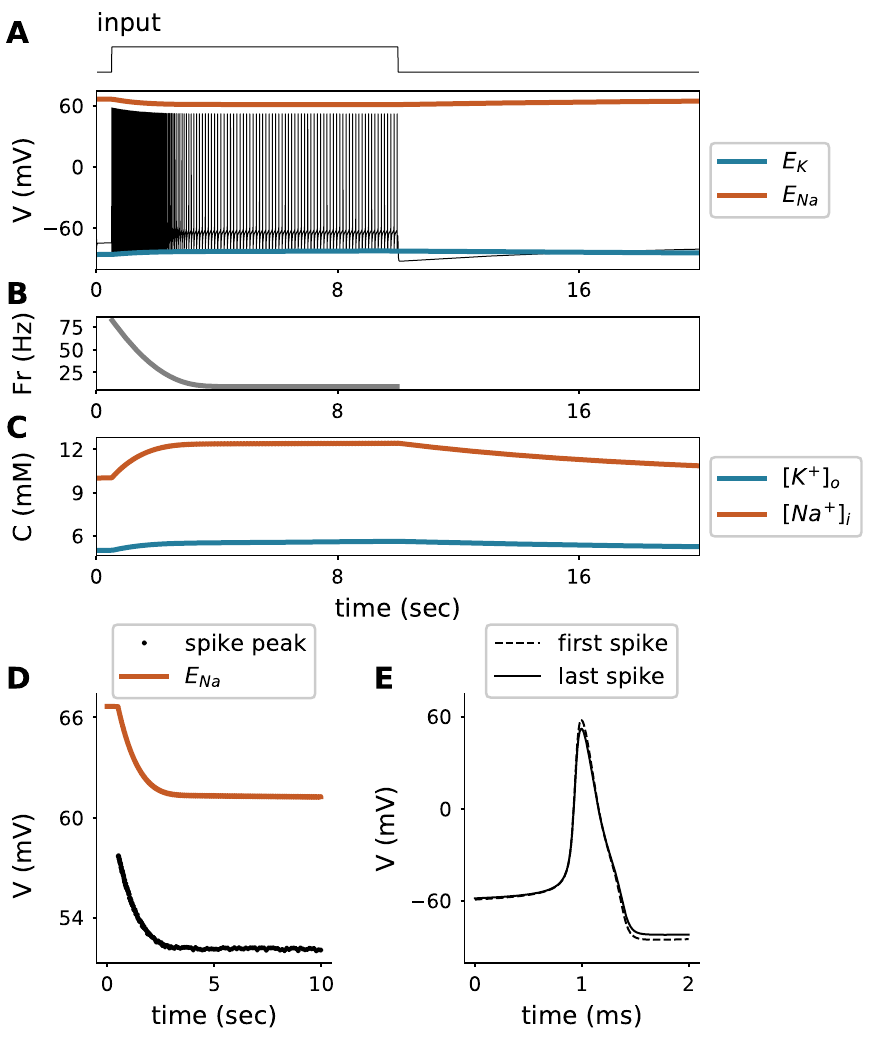
Fig 1. Response of the model to a step current of 2 μA / cm 2 input as shown in the top. A . Voltage trace (V) with reversal potentials for sodium (Orange) and potassium (Blue). B . Firing rate (Fr) of neuron model. C . Intracellular sodium (Orange) and extracellular potassium (Blue) concentration (C) dynamics. D . Spike amplitude and reversal potential for sodium (Orange) for the trace shown in A . E . First and last spike (peaks